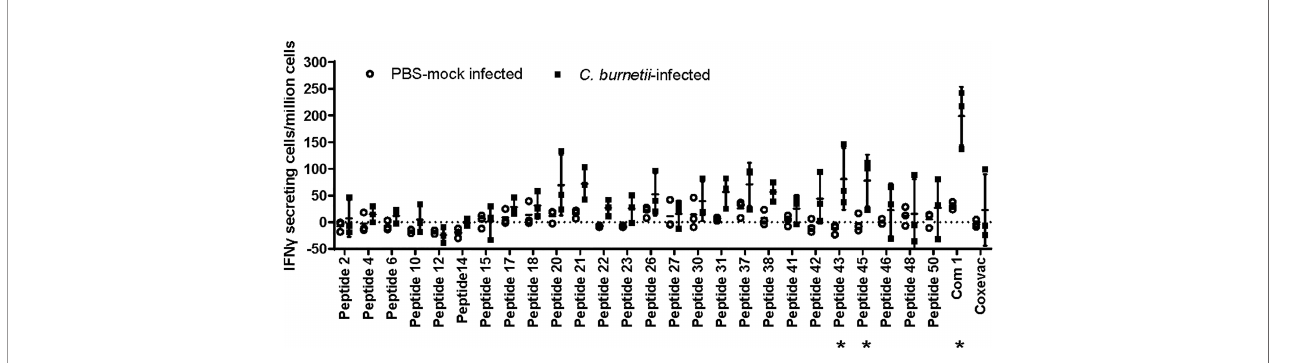
FIGURE 1 | Antigenic recall responses in Coxiella -infected C57BL/6 mice. C57BL/6 mice (n=3 per group) were infected intranasally with 1x10 5 GE of C. burnetii Nine Mile strain, or mock-infected with PBS. Mice were terminated at day 51 post-infection and splenocytes recovered for ELISpot analysis. Splenocytes were stimulated with individual peptides, recombinant Com1, or the veterinary vaccine Coxevac in the presence of costimulants anti-CD28 and anti-CD173. Data are presented as IFN g -secreting cells (spot-forming units)/million splenocytes; bars indicate group mean and standard deviation. * = p <0.05 for differences between mock-infected and C. burnetii -infected animals by two-way ANOVA with Sidak ’ s multiple